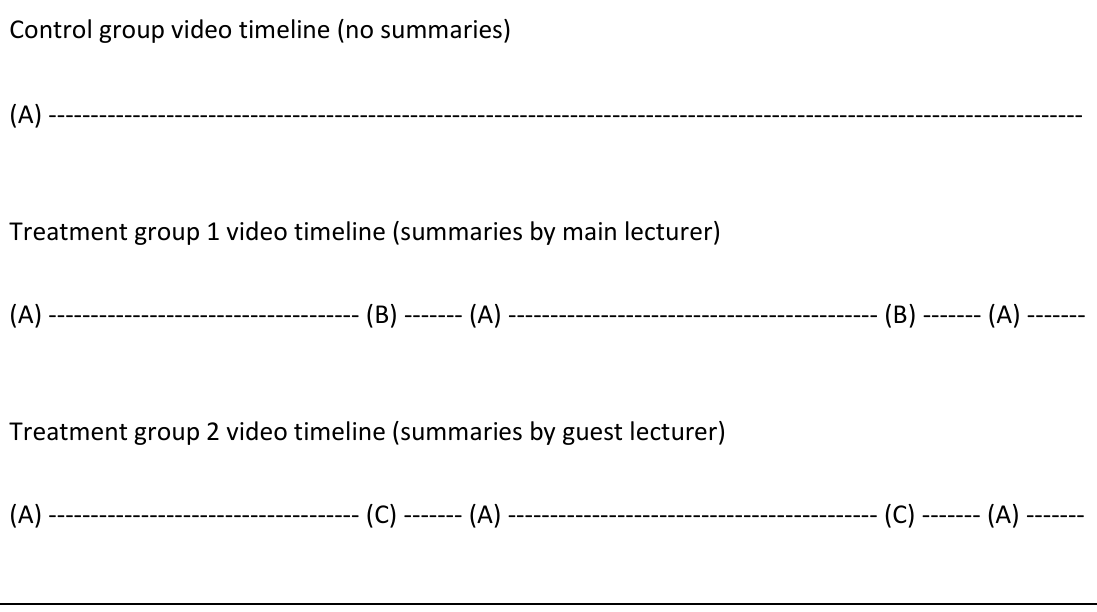
Figure 3. Summary of the video timelines. The letters A-C correspond to the style of videos shown